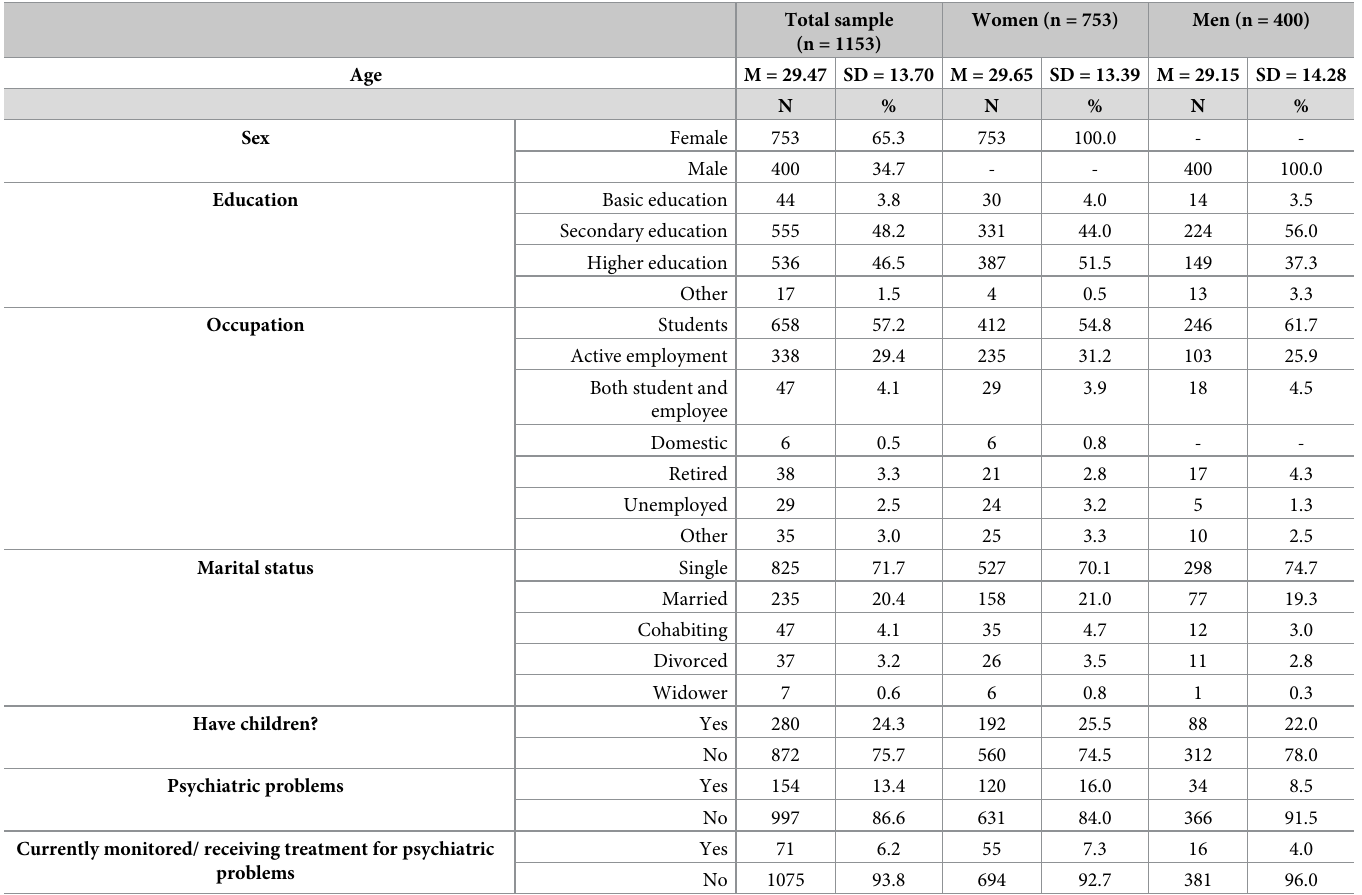
Table 1. Sample’s demographic